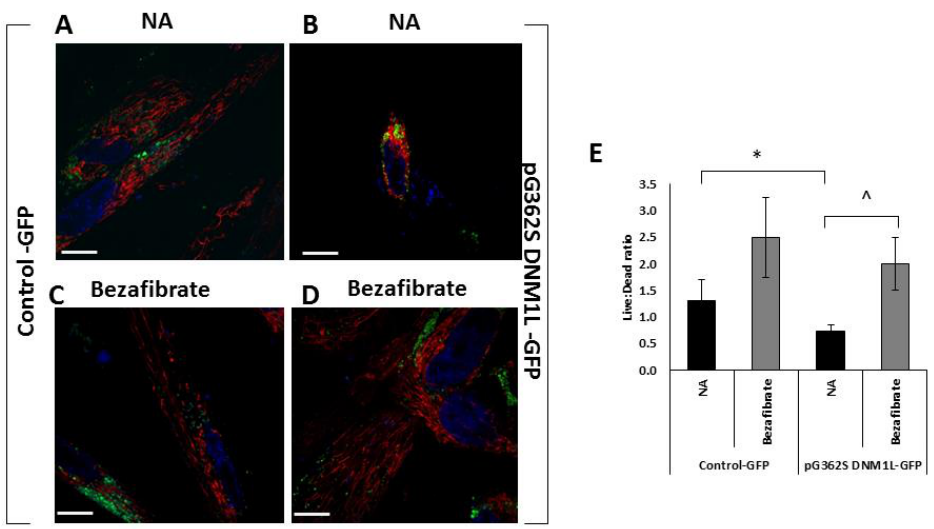
Figure 3. Mitochondrial morphology and viability of human foreskin fibroblast (HFF-1) cells expressing the p.G362S DNM1L mutation. Human foreskin fibroblasts, transformed with a control plasmid expressing GFP ( A,C ) or a plasmid expressing GFP and p.G362S DNM1L mutation ( B,D ), were seeded in 35mm glass-bottom tissue culture plates 72 h post-transformation. The following day, the medium was replaced with fresh high-glucose medium without ( A,B ) additive (NA) or in the presence of bezafibrate ( C,D ) and incubated for 72 h. Mitochondrial morphology was visualized by MitoTracker Red CM-H2XRos (red) and was examined in cells expressing GFP (green) by fluorescence microscopy. Nuclei were stained in blue. Scale bar = 10 µM. In parallel experiments, cell viability was measured by trypan blue and the results are depicted in the histogram ( E ) ± SEM; * p < 0.05 compared to NA control; ^ p < 0.05 compared to the same cell with no additive.